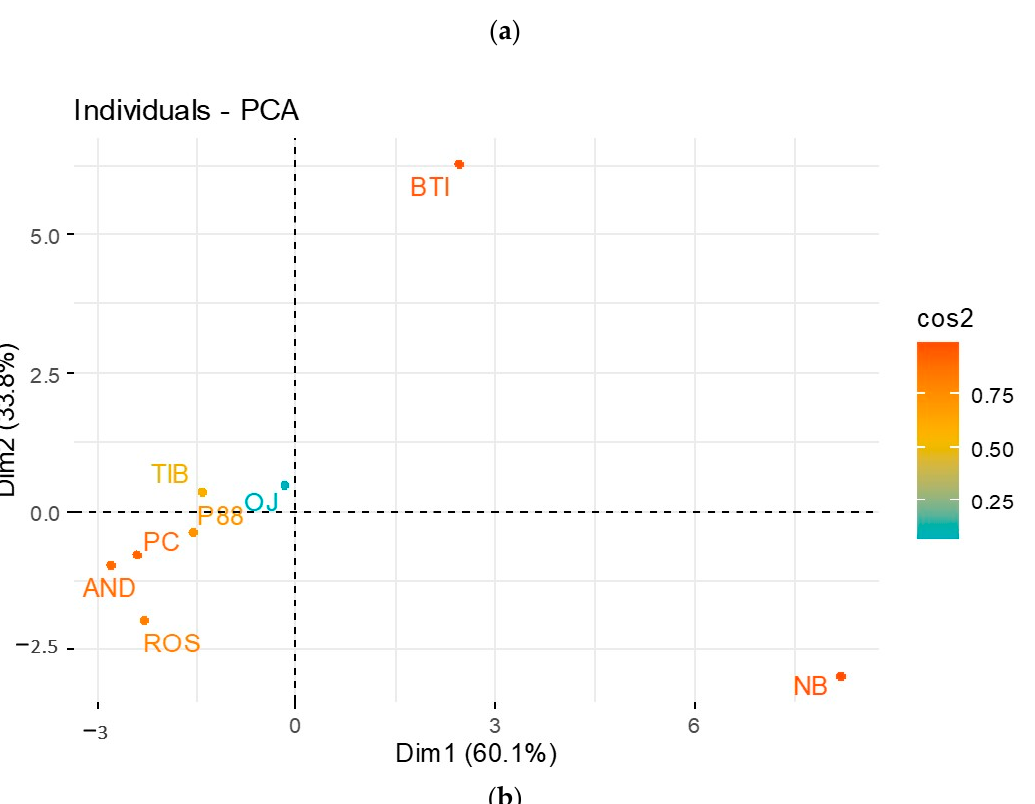
Figure 2. PCA plot released on the eight cultivars for the 20 molecules retained in the fingerprint of Noir de Bourgogne. Cultivars labels: Ben Tiran (BTI), Tiben (TIB), OJ-5-3 (OJ), 88-04-181 (P88), PC110 (PC), Andega (AND), Rosenthal (ROS), and Noir de Bourgogne (NB). ( a ) Representation of the variables in plan Dim1-Dim2; ( b ) Representation of the individuals (Figure 2b) on the factor map. Two dimensions accounted for 93.8% of the total variance. All variables (volatile compounds) were well represented with cos2 > 0.9.